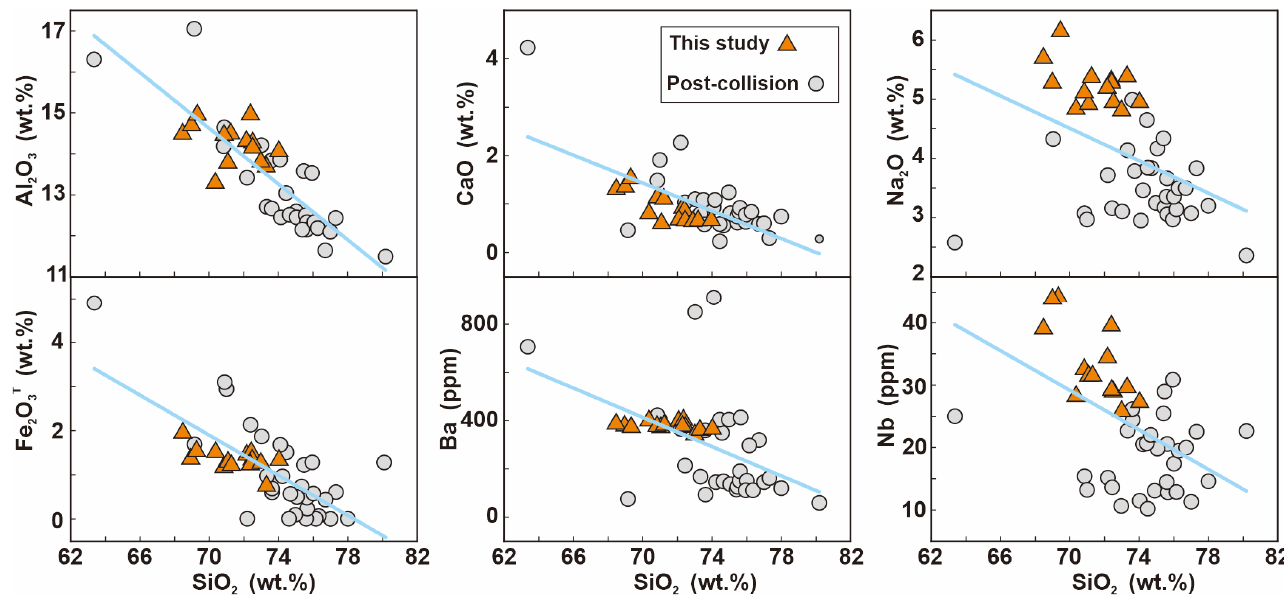
Figure 11. Harker diagrams for granitoids from the middle Huaniushan arc. Geochemical data of post − collision from [18,22–26].